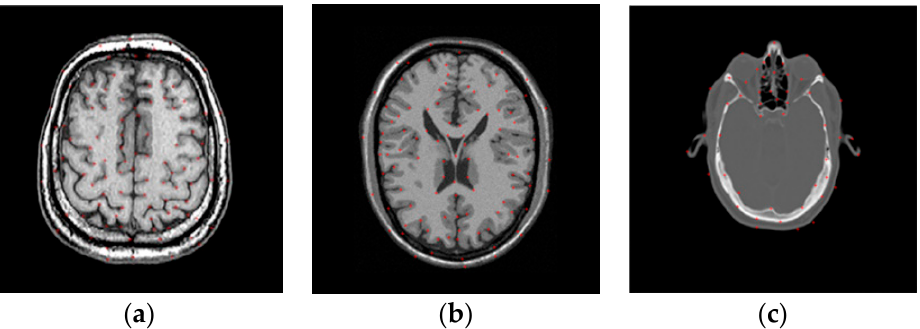
Figure 3. Distribution of landmarks in the reference images from the three datasets. ( a ) Atlas dataset; ( b ) BrainWeb dataset; ( c ) RIRE dataset.